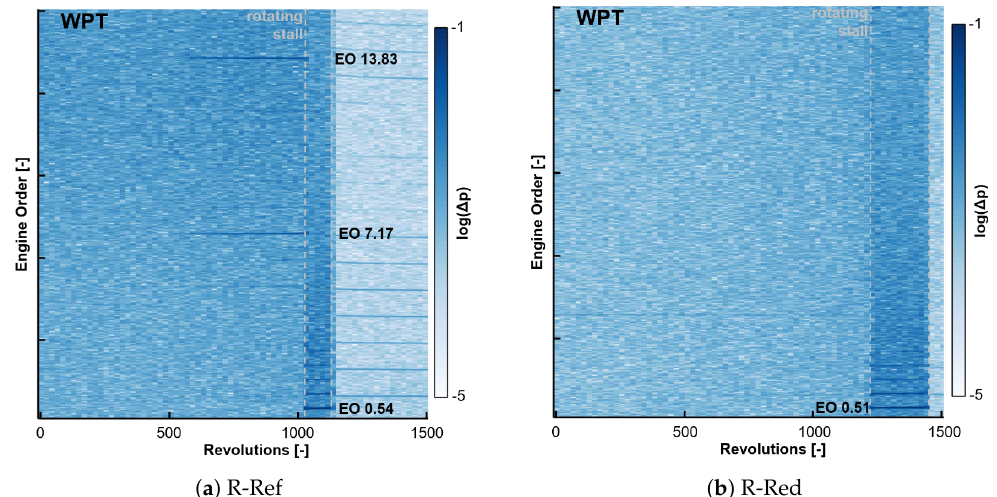
Figure 9. WPT Spectra for Stall Inception at Design Speed.